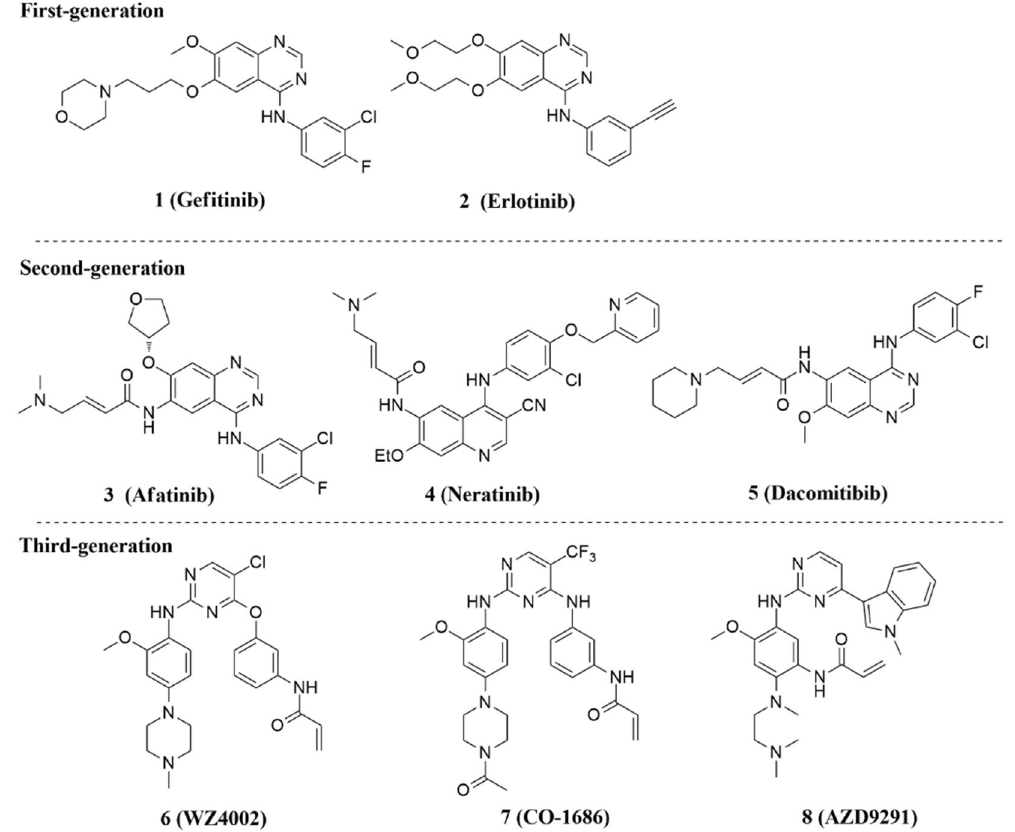
Figure 1. Structures of first-, second- and third-generation EGFR